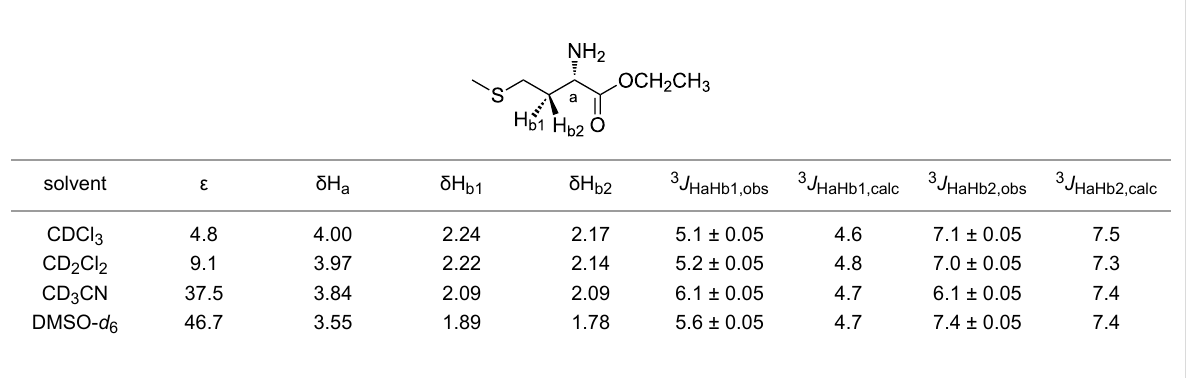
Table 3: Experimental and calculated 1 H NMR data for the compound 1 in different solvents. The chemical shifts values are given in ppm and the 3 J HH coupling constants in